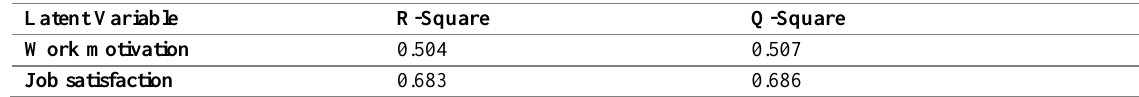
Table 4: Structural Model Analysis